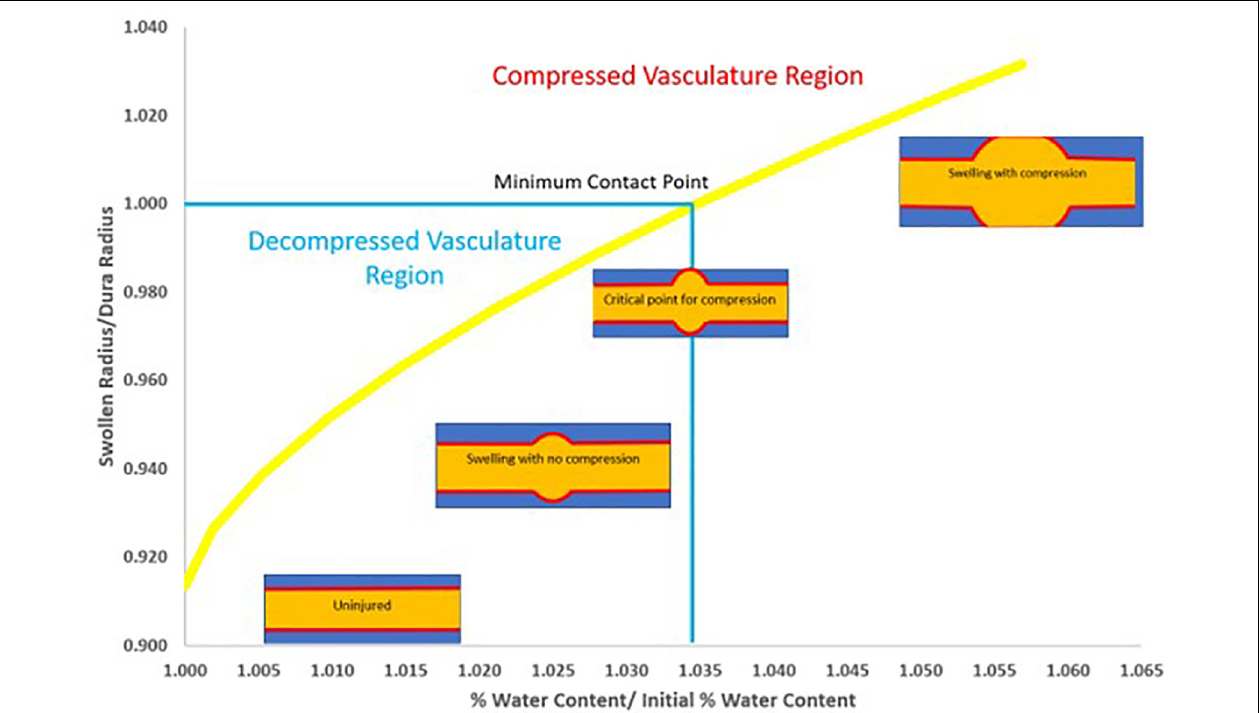
FIGURE 5 | Calculated illustration of relationship between changes in % water content and potential subarachnoid and vascular compression due to radius swelling. Graphic is based on a typical uninjured cord radius of 1.48 mm (Soubeyrand et al., 2014a), an overall radius including the subarachnoid space of 1.62 mm (Soubeyrand et al., 2014a) (radii ratio of 0.913), a 5 mm segment and an uninjured spinal cord water content of 69.4% (normalized as 1.0% water content/initial % water content). Based on measured size of the excised tissue in this study and the assumption of spherical swelling in a cylindrical vessel, a % water content ratio increase of only 0.035 (equivalent to a % water content increase of 71.8%) results in a swelling radius at the threshold for constriction of the subarachnoid space and potential collapse of the local vasculature (radii ratio of 1.0). Although this is only an estimate, nevertheless, these results imply that even relatively small reductions in edema may support reduced vascular compression that may help improve